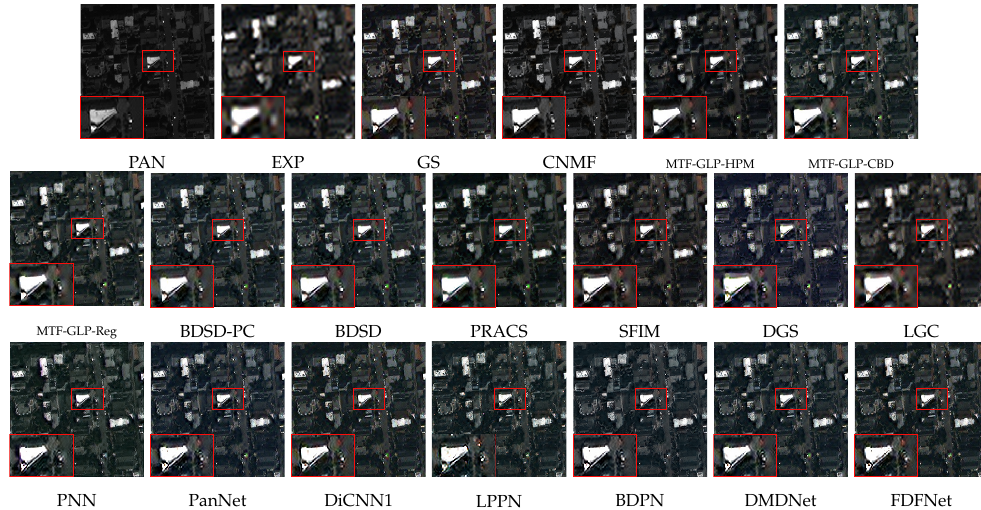
Figure 13. The visual comparisons on a full-resolution QB case (shown by bands: 1, 3, and